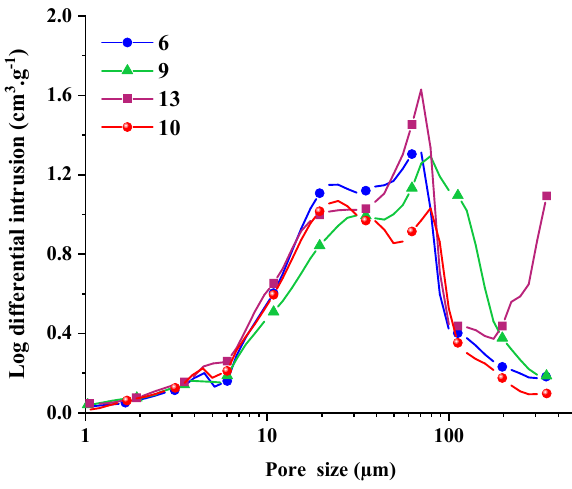
Figure A1. Pore size distribution calculated using Equation (3).